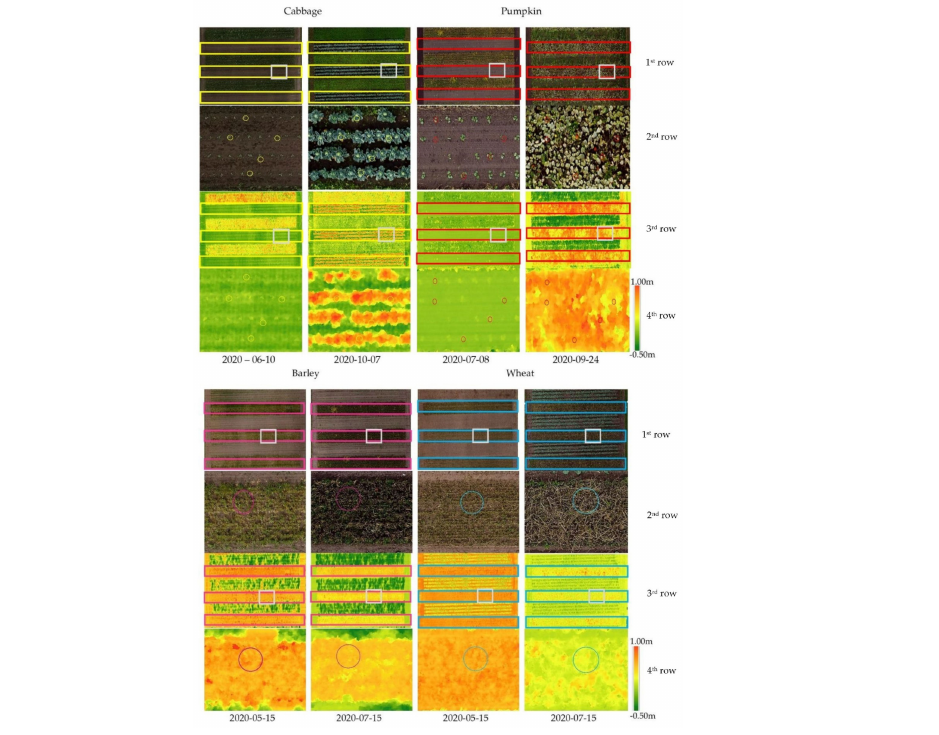
Figure 5. Visualization of the UAV-derived development of crop height in meters, as shown in orthomosaics and crop height models (CHMs) at the beginning and the end of the growing season. The CHMs were computed by subtracting DSM from DTM. A part of the orthomosaics and CHMs zoomed into one of the strips showing both the area with and without buffer. The colors in CHMs correspond to the value of the crop